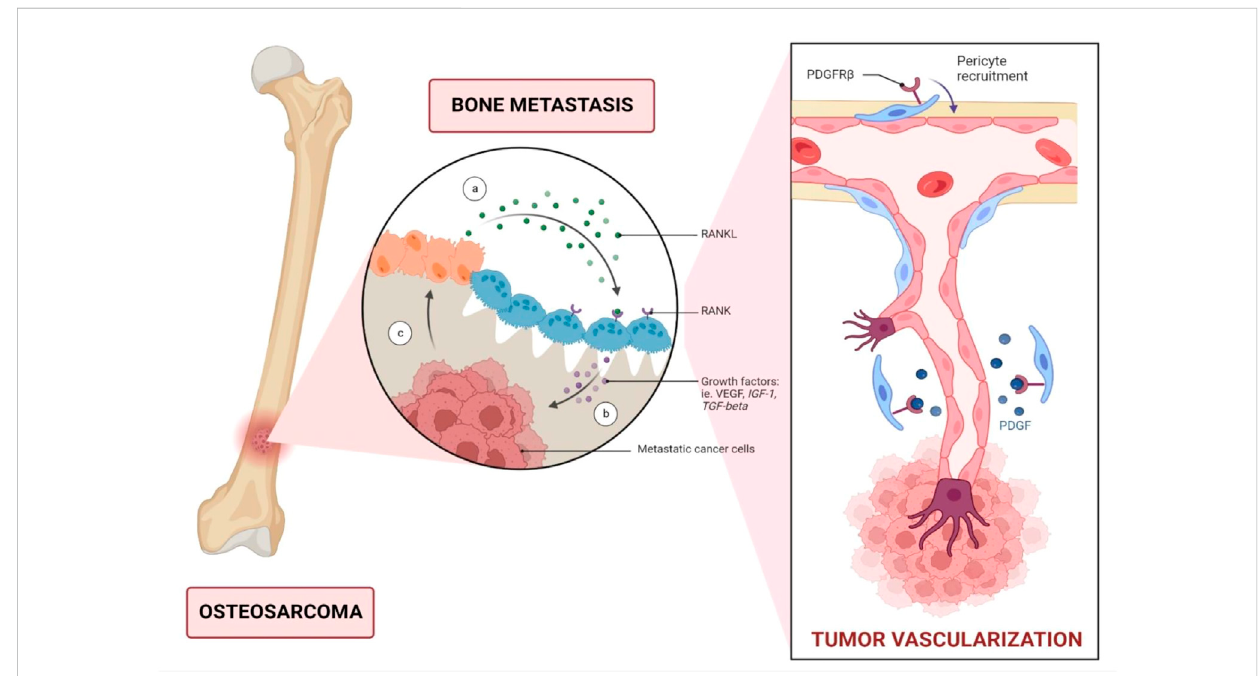
Metastatic dissemination of bone cancer through vascular endothelial growth factor (VEGF). VEGFR is a key angiogenic factor that promotes endothelial cell proliferation and consequently enhances vascular endothelial permeability. In patients with osteosarcoma, serum VEGF levels can serve asapredictivebiomarker,withhighVEGFexpressioncorrelatedwithapoorprognosis.Abbreviations:RANKL;Receptoractivatorofnuclearfactorkappa- B ligand; IGF-1, Insulin-like growth factor 1; TGF-beta, Transforming growth factor beta; PDGFR β , Platelet derived growth factor receptor